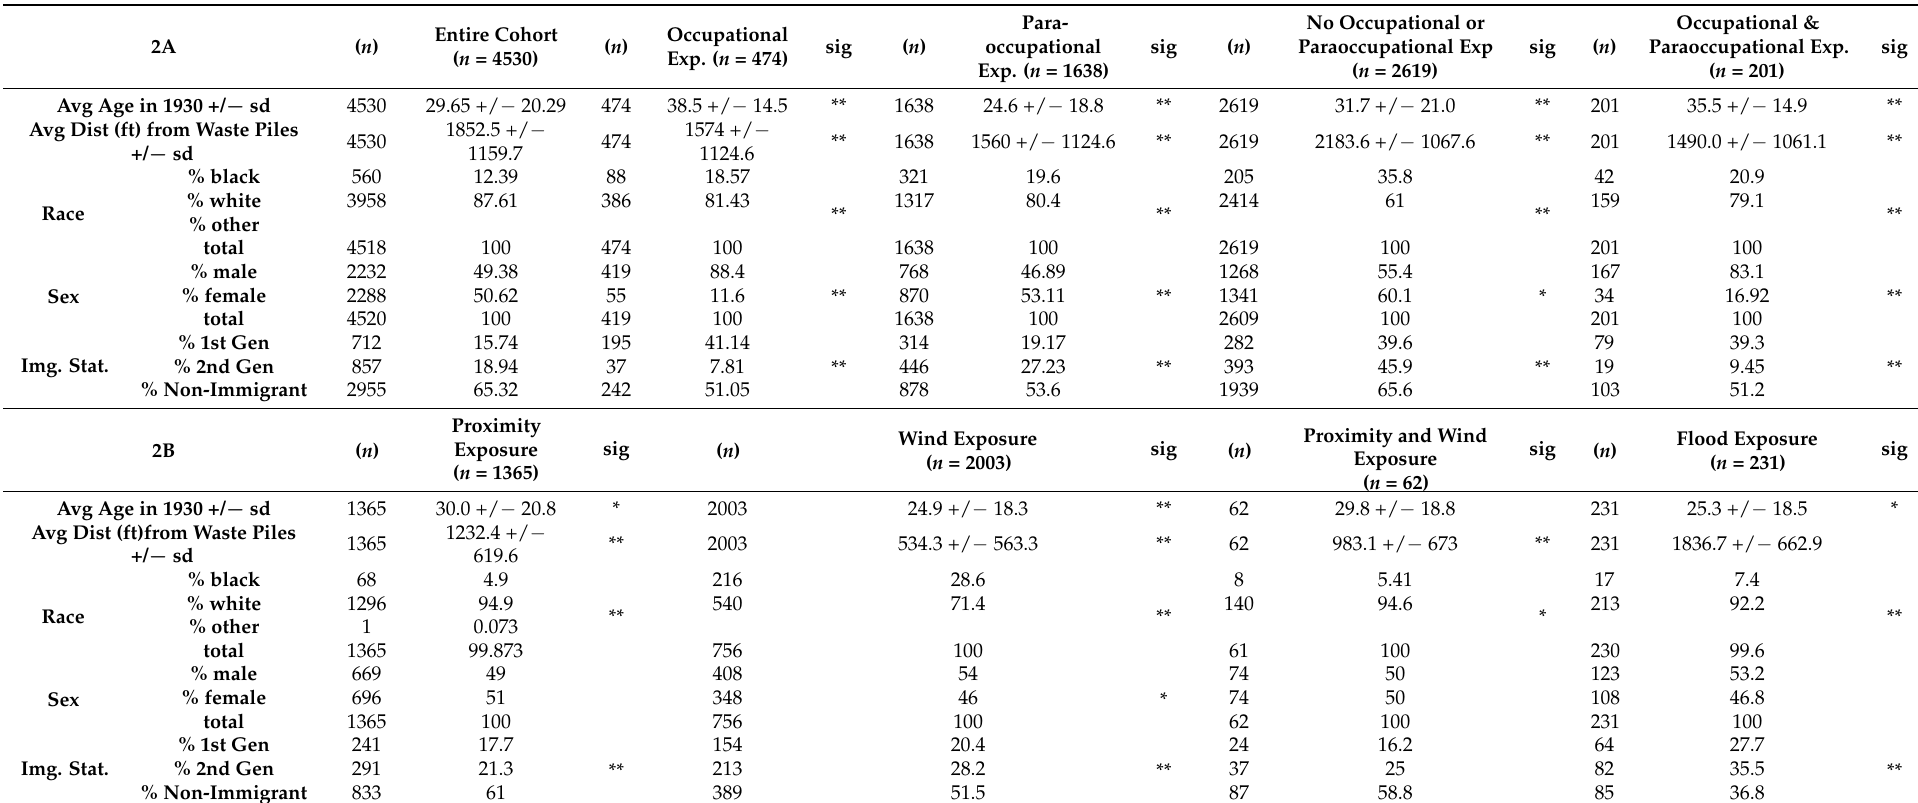
Table 2. Itemized exposure profile by race, gender and immigration